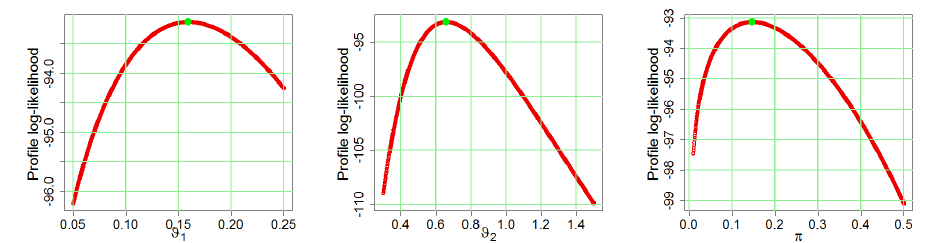
Fig. 18. The PLLF for for Dataset I